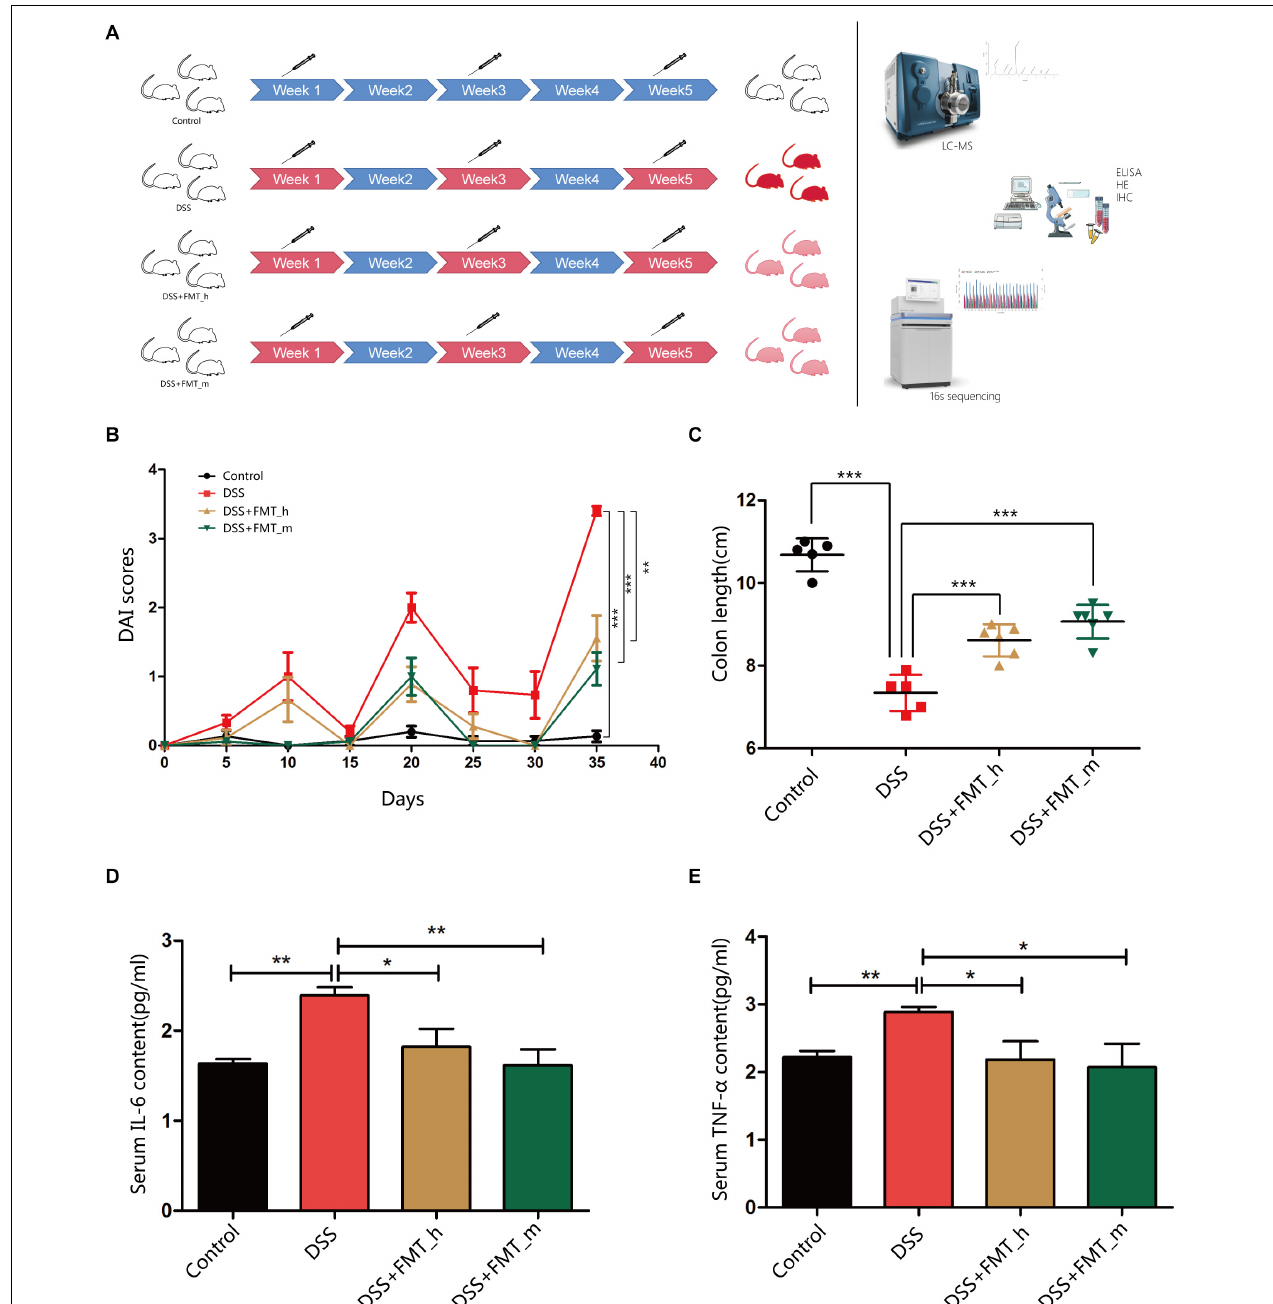
FIGURE 1 | FMT with the gut microbiota from healthy donors or mice significantly ameliorates clinical symptoms and inflammation in colitis mice. BALB/c mice were randomized and fed with normal water as the control or water containing 2.5% DSS to induce colitis. The control and some DSS-fed mice (DSS group, n = 6) were fed with PBS, whereas other DSS-fed mice were fed with fresh human or mouse fecal microbiota as the DSS + FMT_h or DSS + FMT_m group ( n = 6 per group). (A) Schematic diagram of the experimental design. The degrees of red colors indicate the severity of colitis. (B) The dynamics of Disease Activity Index (DAI) in each group. (C) Mouse colon lengths in each group. (D) The levels of serum IL-6. (E) The levels of serum TNF- α . Data are individual means or the mean ± SD of each group from three separate experiments. * p < 0.05, ** p < 0.01, *** p < 0.001.